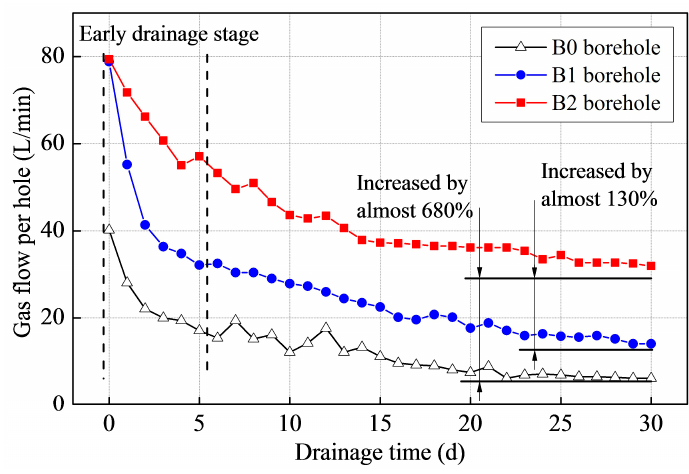
Figure 7. Comparison of the gas drainage rates for three boreholes. B0 not fractured; B1 fractured using conventional hydraulic fracturing; B2 fractured using tree-type hydraulic fracturing.